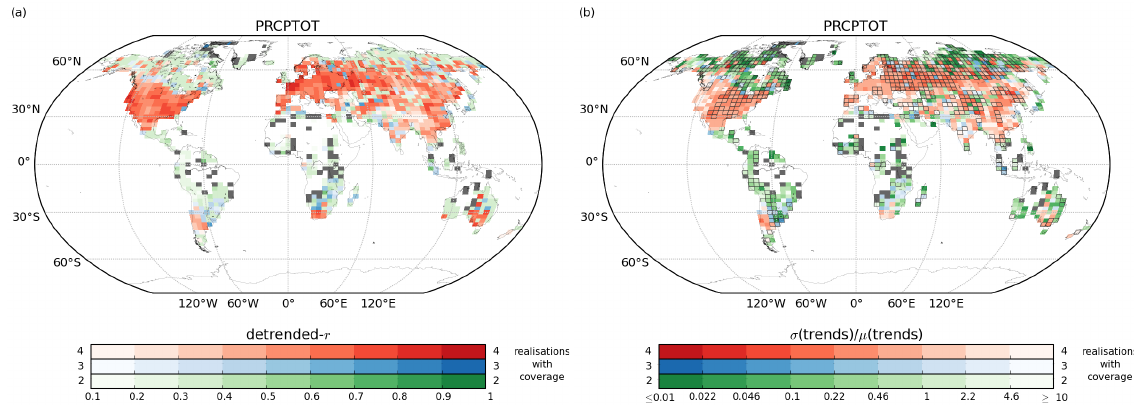
Figure 16. (a) The mean correlation coefficient of the detrended time series, r with HadEX2 for all the grid boxes and (b) the standard deviation of the trends divided by the mean trend ( σ/µ ) calculated for the period 1951 to 2010 for PRCPTOT and the four gridding methods. Grey grid boxes are those where only one of the five possible gridding methods results in a value, green where two, blue where three, and red where all four of the possible choices. For further details see Fig. 5.